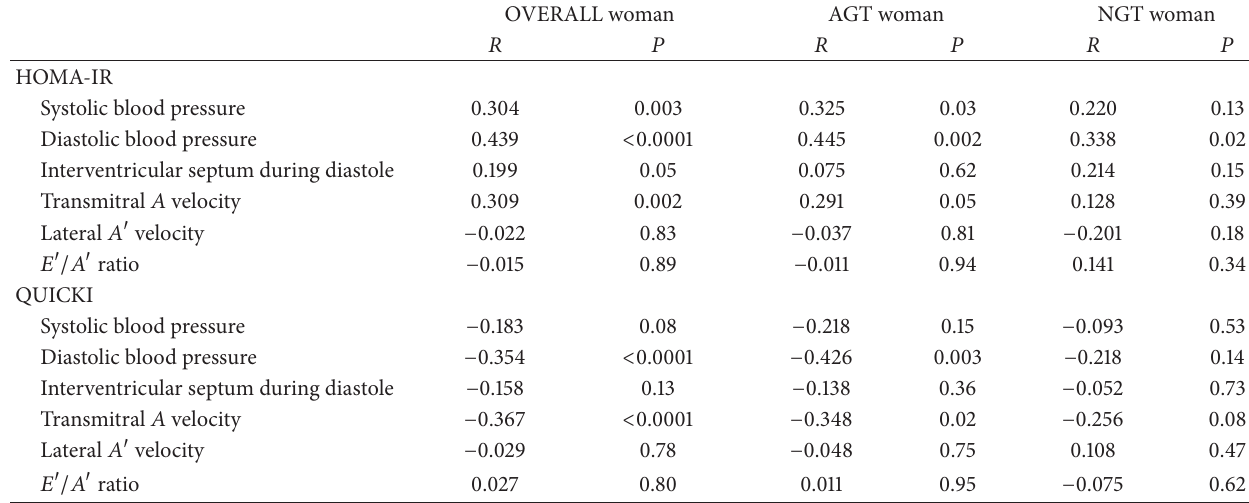
Table 4: Correlation analyses between HOMA-IR, QUICKI, and significantly different cardiovascular